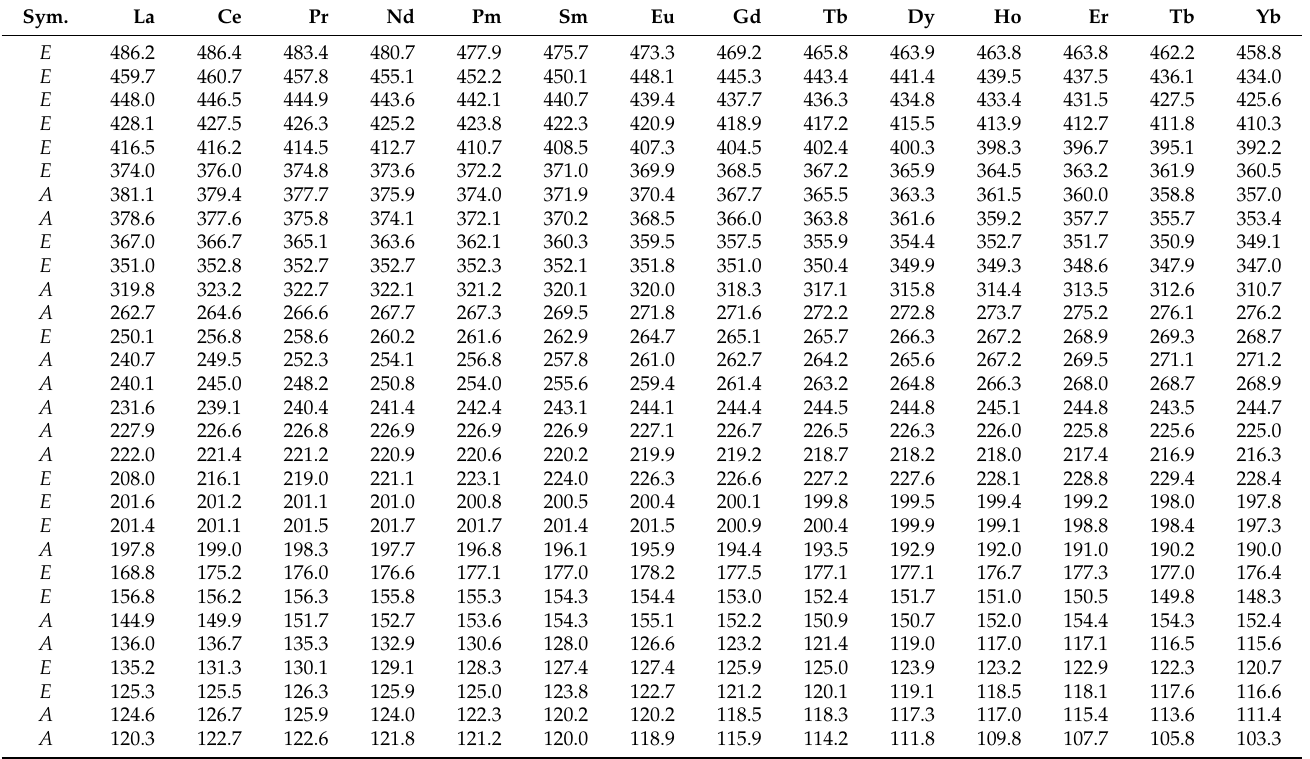
Table A2. Raman frequencies (in cm − 1 ) calculated for the silicide bilayer with ( earths within DFT-PBEsol. Only phonon modes localized by more than 50% within the atomic layers Si 1 -Si 5 are shown. The localization is calculated in the case of terbium silicide.